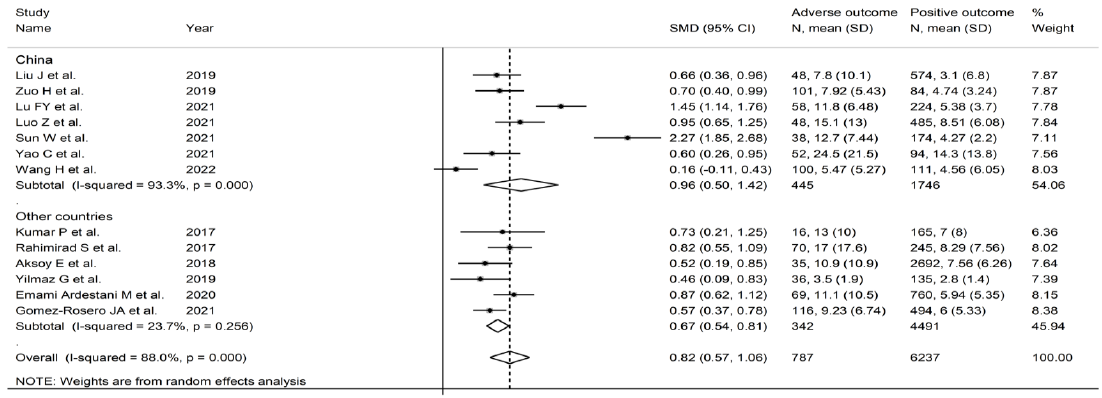
Figure 11. Forest plot of the association between the neutrophil-to-lymphocyte ratio, using standard mean differences, and adverse outcomes according to specific endpoints (mortality vs. other outcomes). p = 0.000 indicates a p -value < 0.001.